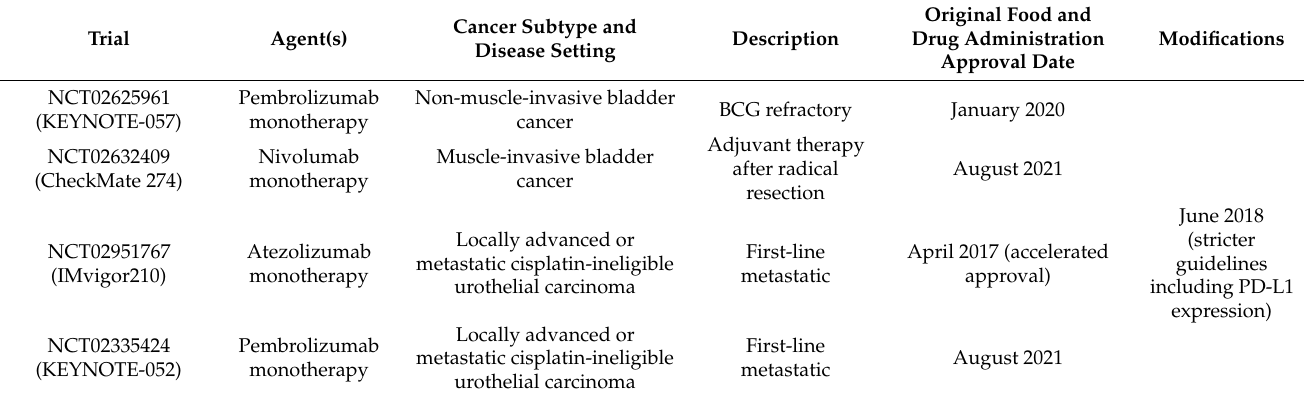
Table 1. Trials containing immune checkpoint inhibitors that led to Food and Drug Administration (FDA) approval to treat genitourinary